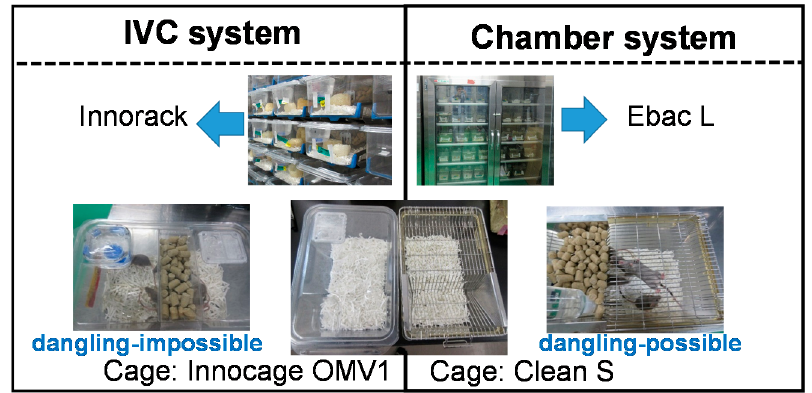
Figure 1. Two di ff erent types of housing cages: chamber (right) and IVC (individually ventilated cages) Figure 1. Two different types of housing cages: chamber (right) and IVC (individually ventilated (left) cages) (left) types.